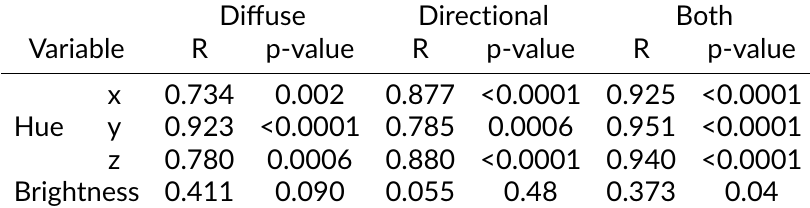
Supplementary figure 3 – Study sites locations (red dots) plotted on an altitudinal map of Ecuador. Communities outside the borders of the map are on islands or close enough to Ecuador borders to be taken into account in our study. Diffuse Directional